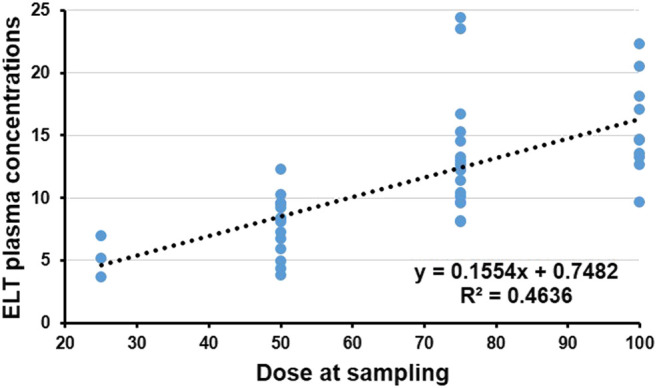
Plasma concentration and dose of Eltrombopag (ELT). The regression equation of the relationship between the dose of ELT and concentration was successfully determined (Y = 0.7482 + 0.1554X, p < 0.001). The plasma concentration of ELT was significantly positively correlated with the daily dose of ELT (r
2 = 0.4636, p < 0.001).